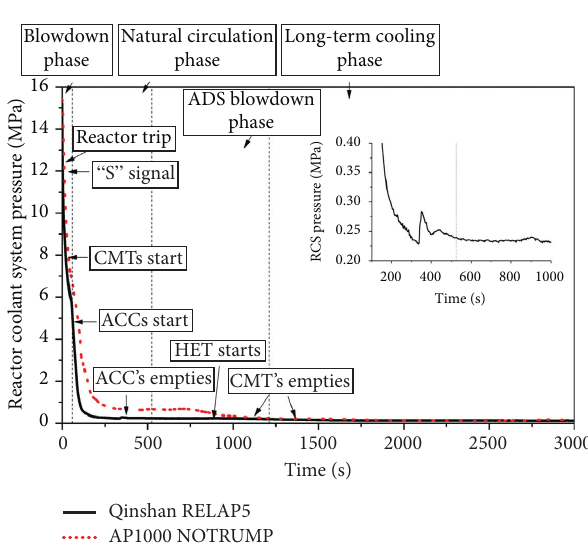
Figure 5: 10-inch CL break RCS pressure transient.